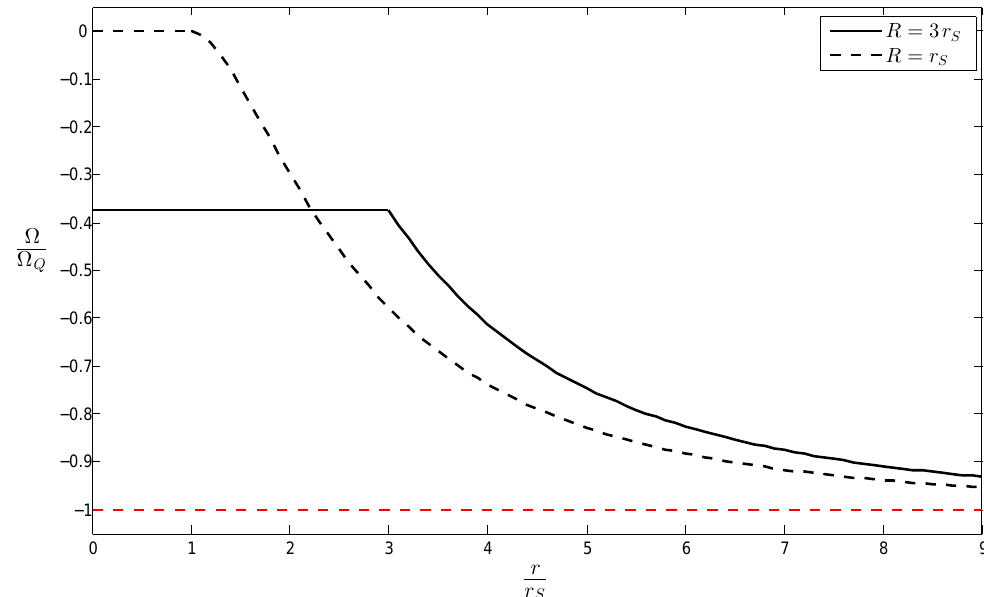
Figure 3. Plots of the angular velocity Ω ( r ) of ZAMOs, as given by the expression in Equation (34), with vanishing angular velocity for the shell, ω s = 0, and r Q → ∞ , as in Figure 2. Note that here, Ω ( r ) is normalized by Ω Q